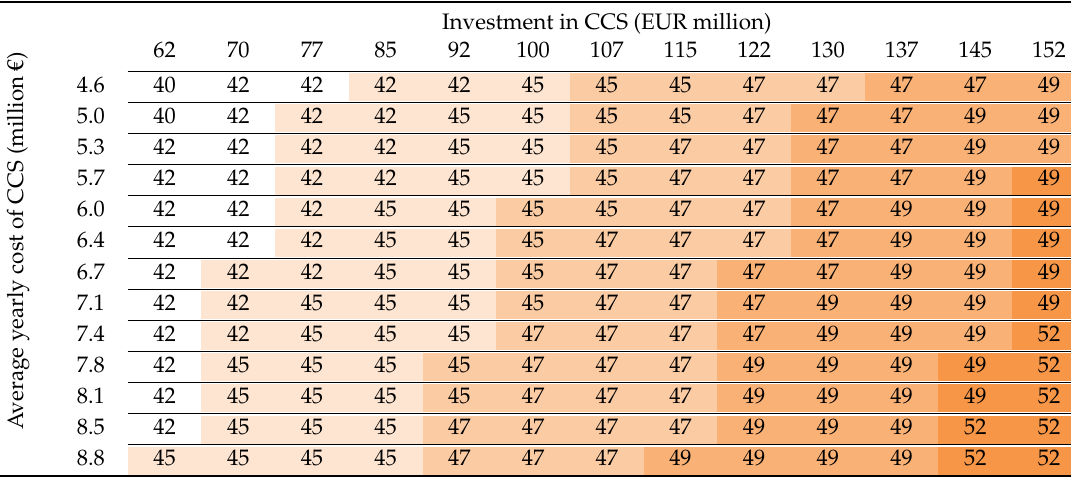
Table 15. Limit price of CO 2 allowances for CCS profitability (EUR)—hard coal